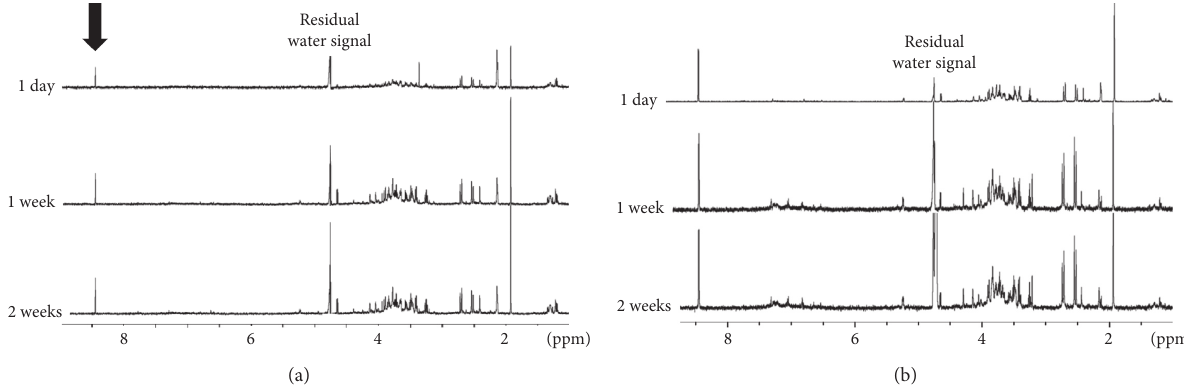
Figure 5: 1 H zgcppr NMR spectra of nanoCaCO 3 @PAE suspension at basic pH (a) and acid pH (b). The PAE release was followed for two weeks referred to TSP used as internal